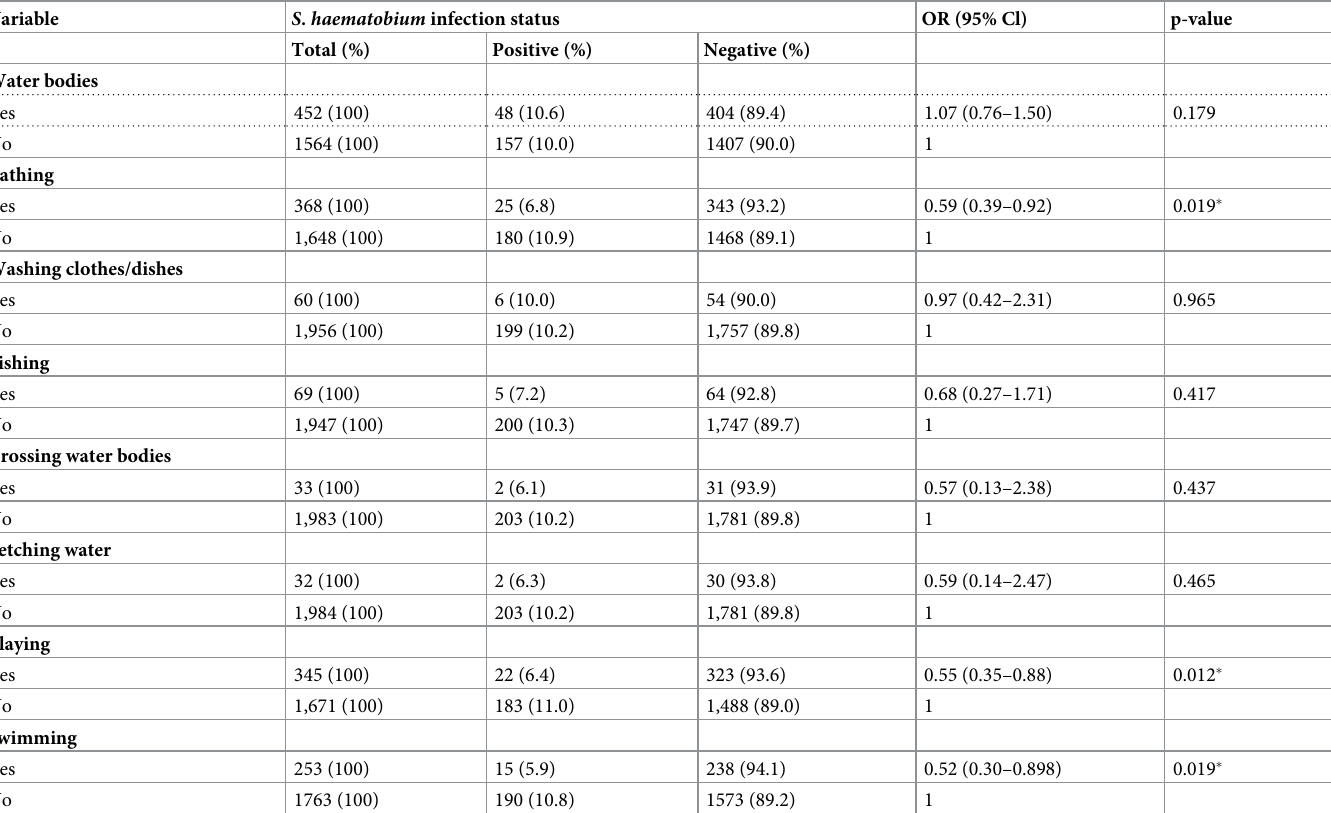
Table 4. Behavioural risk factors of S . haematobium infection in 4 regions of The Gambia,